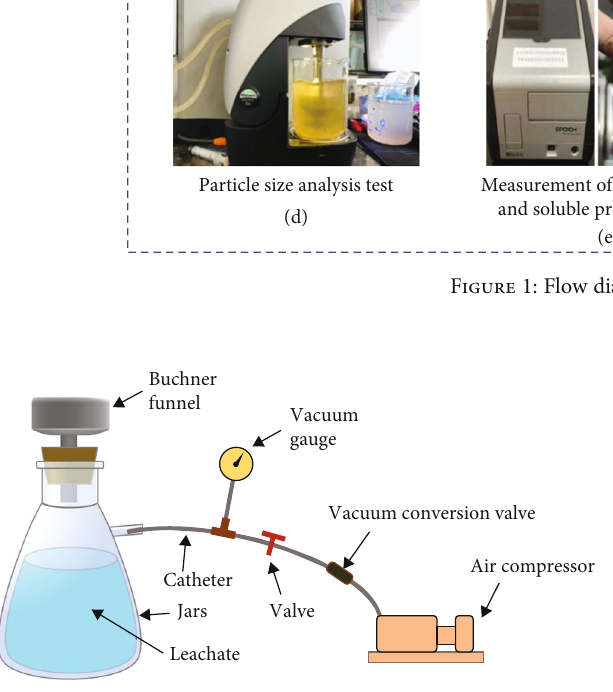
Figure 2: Schematic diagram of vacuum fi ltration